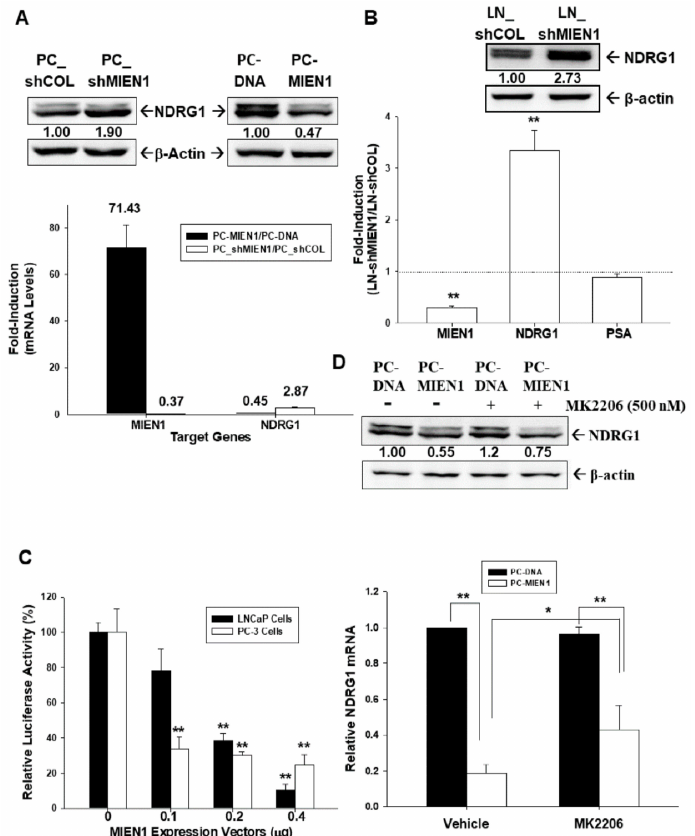
Figure 7. Migration and invasion enhancer 1 (MIEN1) downregulates N-myc downstream regulated 1 (NDRG1) gene expression in prostate carcinoma cells. ( A ) Relative expression of NDRG1 in MIEN1-overexpressing or MIEN1-knockdown PC-3 cells determined by immunoblot (top) and RT-qPCR (bottom; ± standard error (SE), n = 3; the number indicates the fold induction) assays. ( B ) Relative fold induction of MIEN1, NDRG1, or prostate specific antigen (PSA) gene expressions in MIEN1-knockdown LNCaP cells determined by immunoblot (top) and RT-qPCR (bottom) assays ( ± SE, n = 3). The number indicates the ratio of NDRG1 / β -Actin in relation to PC-DNA, LN-shCOL, or PC-shCOL cells. ( C ) The relative luciferase activity of NDRG1 reporter vector after cotransfection with various dosages of MIEN1 expression vector in LNCaP and PC3 cells ( ± SE, n = 6). ( D ) Relative expression of NDRG1 in PC-MIEN1 cells with / without MK2206 determined by immunoblot (top; the number indicates the ratio of MIEN1 / β -Actin in relation to vehicle-treated PC-DNA cells) and RT-qPCR (bottom; ± SE, n = 3) assays. * p < 0.05, ** p <